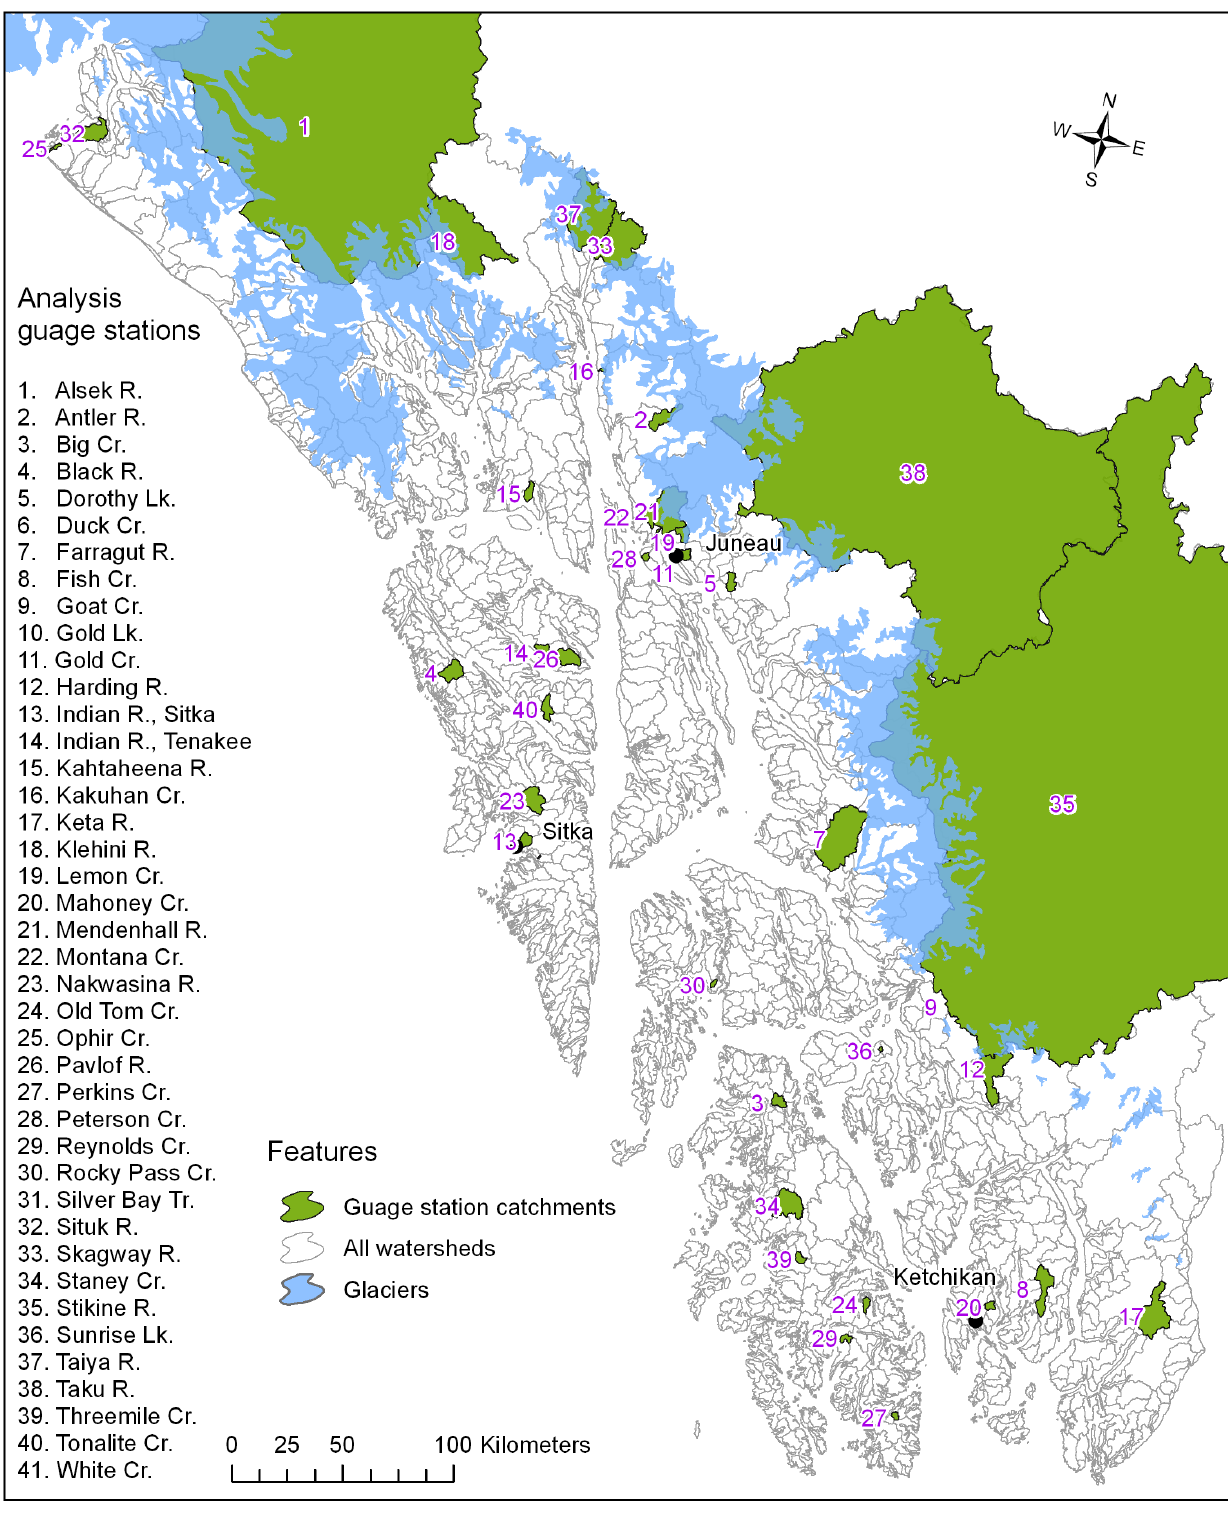
Figure 1. The watersheds of southeast, Alaska, USA, with the 41 gauge station catchments used for the development of regional multiple regression-based monthly discharge models.